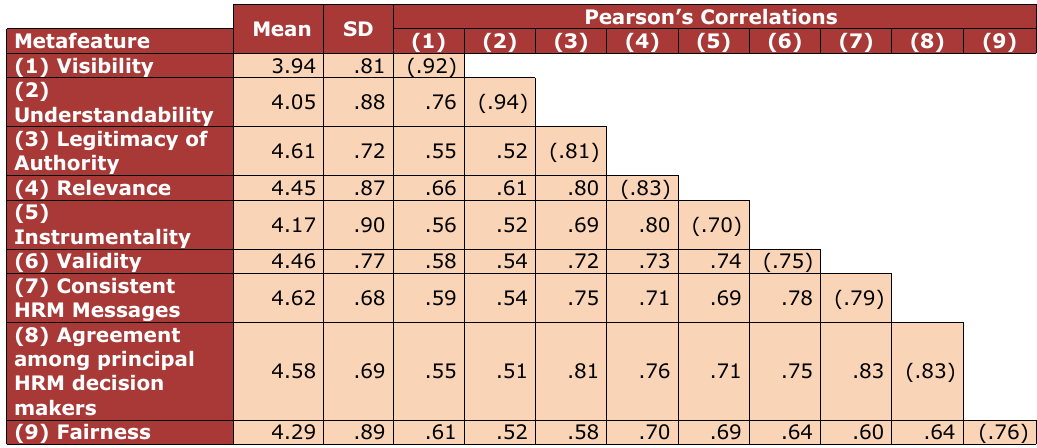
Table 1. Descriptive and reliability